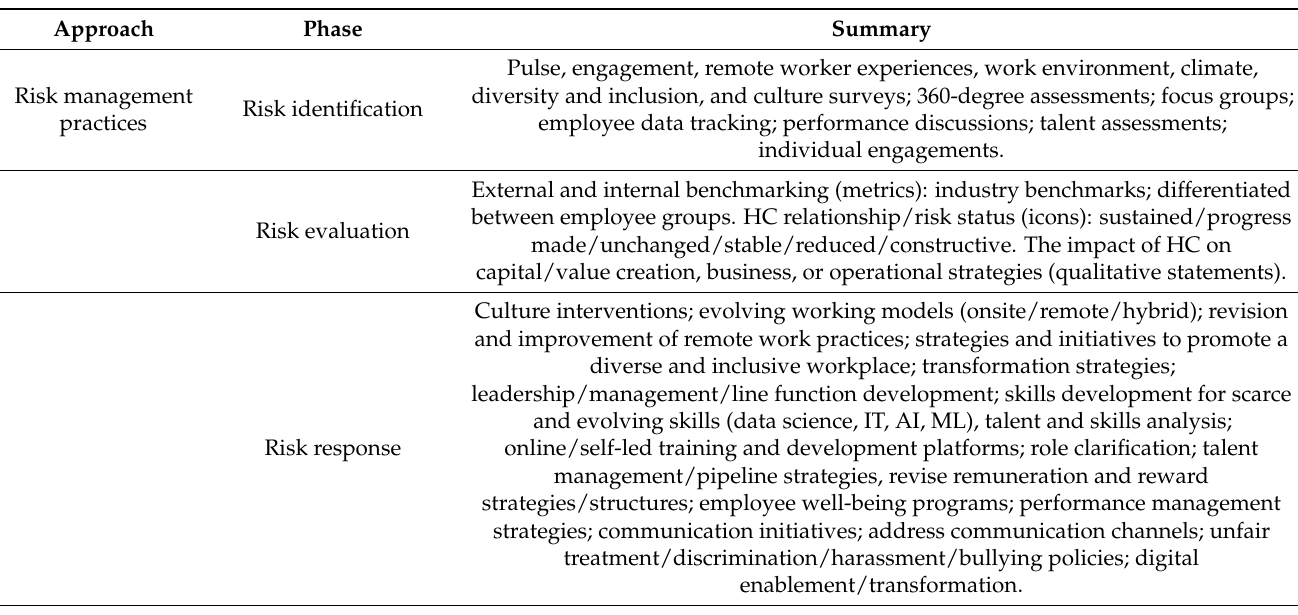
Table 2. Category 1: Risk management approach—Risk management phases.